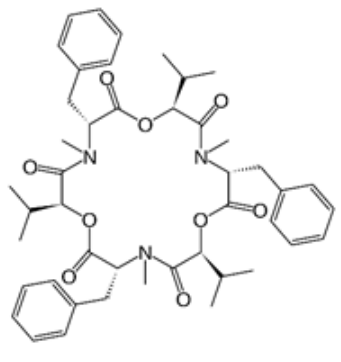
Figure 17. Structure of